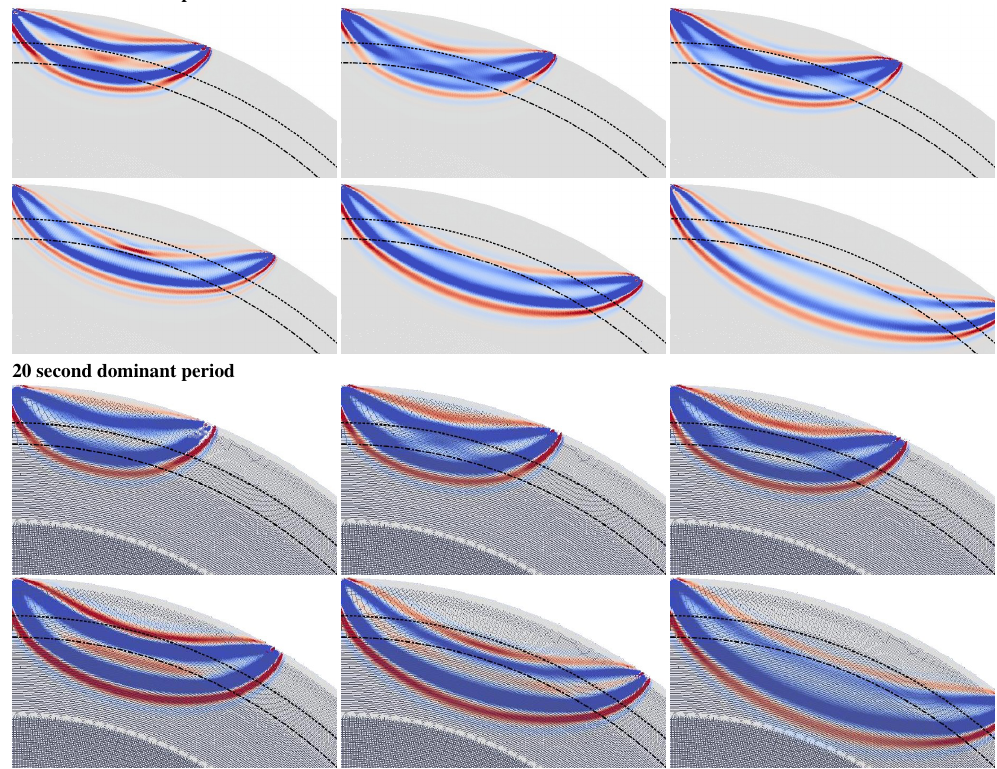
Fig. 5. Traveltime sensitivity kernels for v P , calculated by the Axisem spectral element code. Sensitivities are for a cross-correlation traveltime misfit, in the time window of 5 s before to 15 s after the estimated arrival. Dominant period T is 10 s for the upper two rows, and 20 s for the lower two rows. Distances (from top left): 22 ◦ , 24 ◦ , 26 ◦ , 30 ◦ , 35 ◦ , 40 ◦ . Background model: IASP91 ; source: explosion; receiver: z-component. The 410 -discontinuity is marked by the dashed line, the 660 by the dashed-dotted line. Note that most kernels do not feature the famous doughnut hole, which is filled by the sensitivities to the two discontinuities.